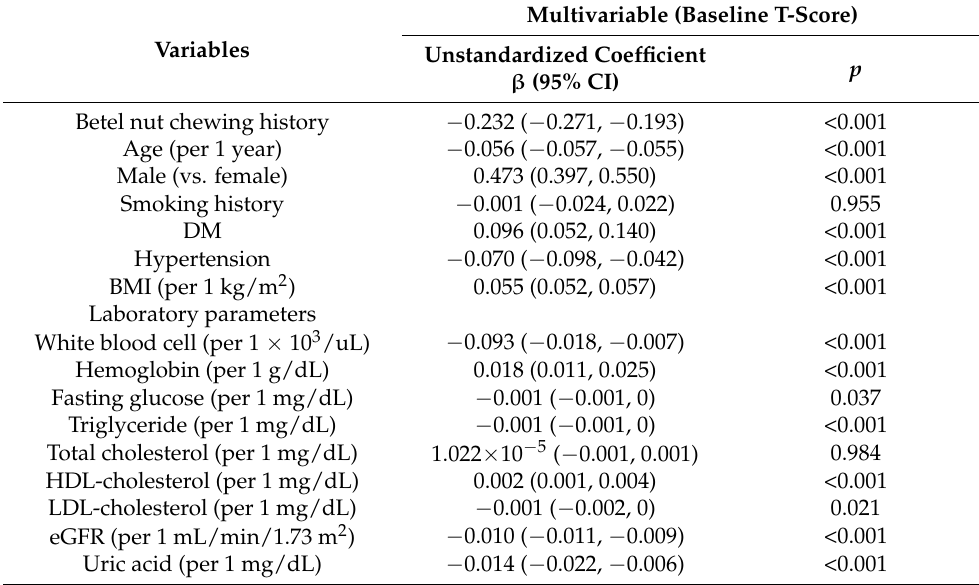
Table 2. Association of betel nut chewing history with baseline calcaneus ultrasound T-score in all study participants ( n = 118,856) using multivariable linear regression